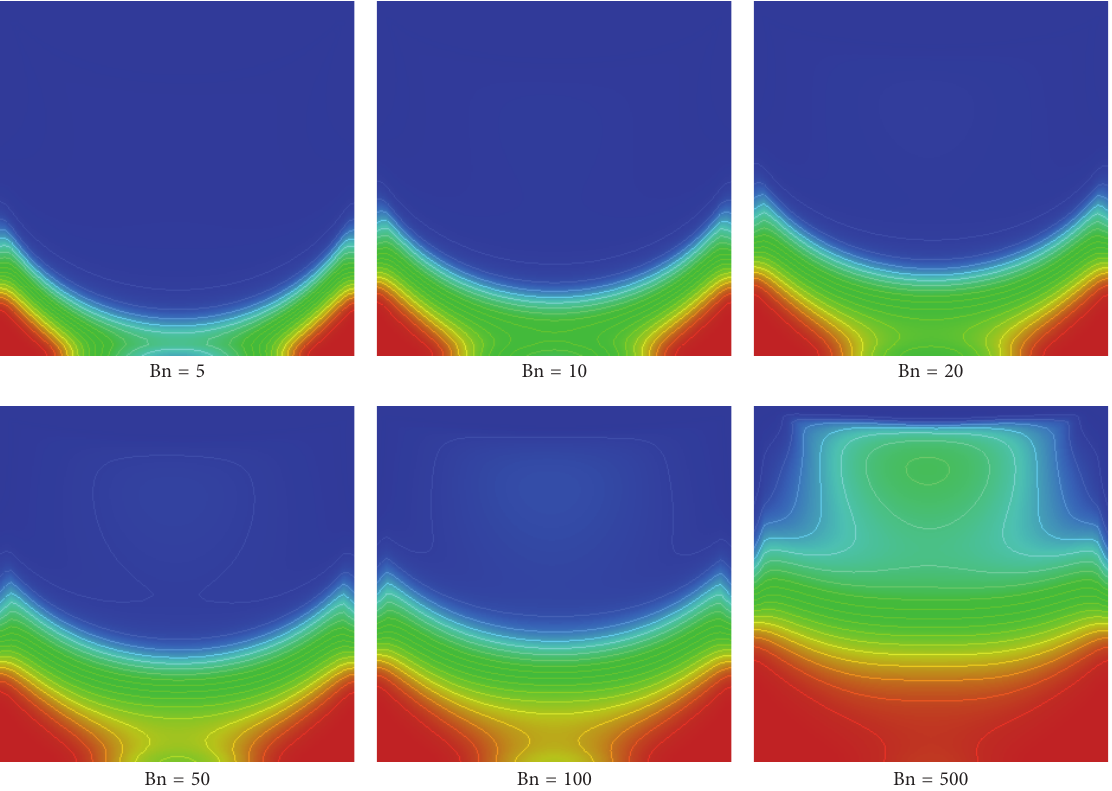
Figure 5: Viscosity contours for different values of Bingham numbers